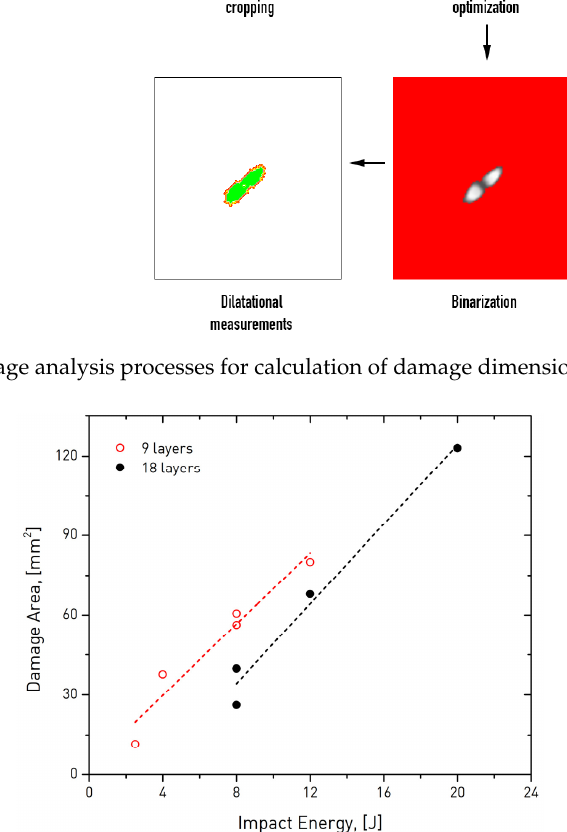
Table 3. Dilatational characteristics of damage caused on thin and thick composite specimens at different impact energy levels.